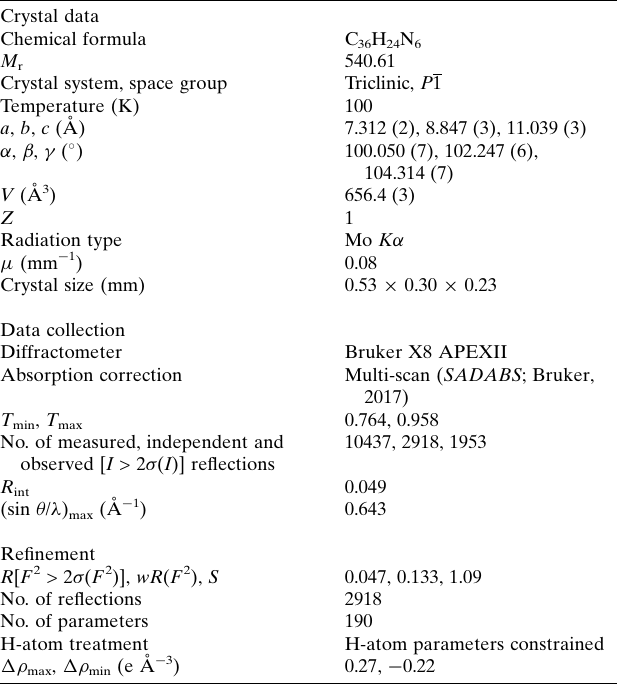
Table 3 Experimental details. Crystal data Chemical formula